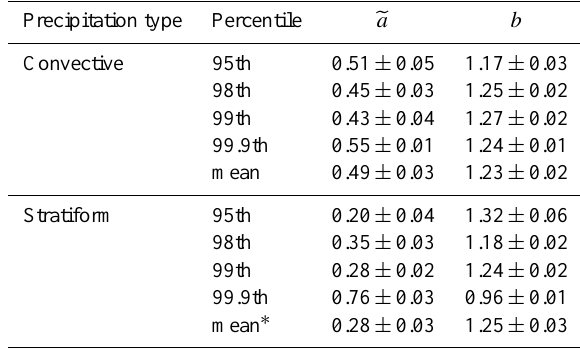
Table 1. Estimation of the exponent b and the pre-factor e a for the different precipitation types and percentiles together with the stan- dard deviation of the parameter